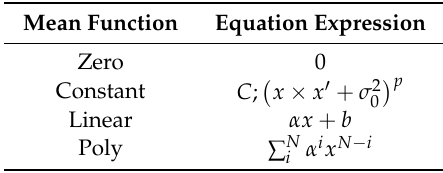
Table 1. Summary of several commonly used mean functions.